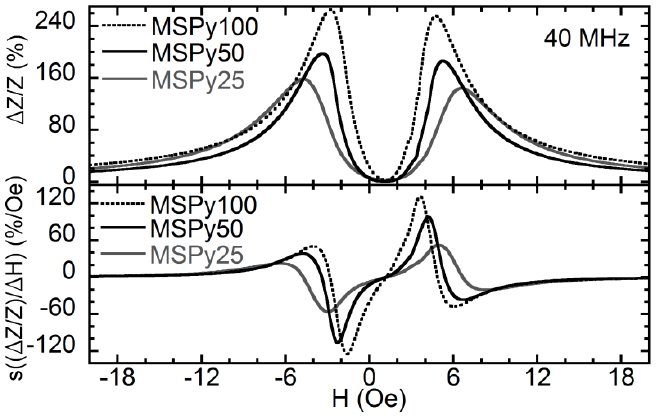
Figure 5. Relative magneto-impedance and sensitivity as a function of the applied magnetic field at 40